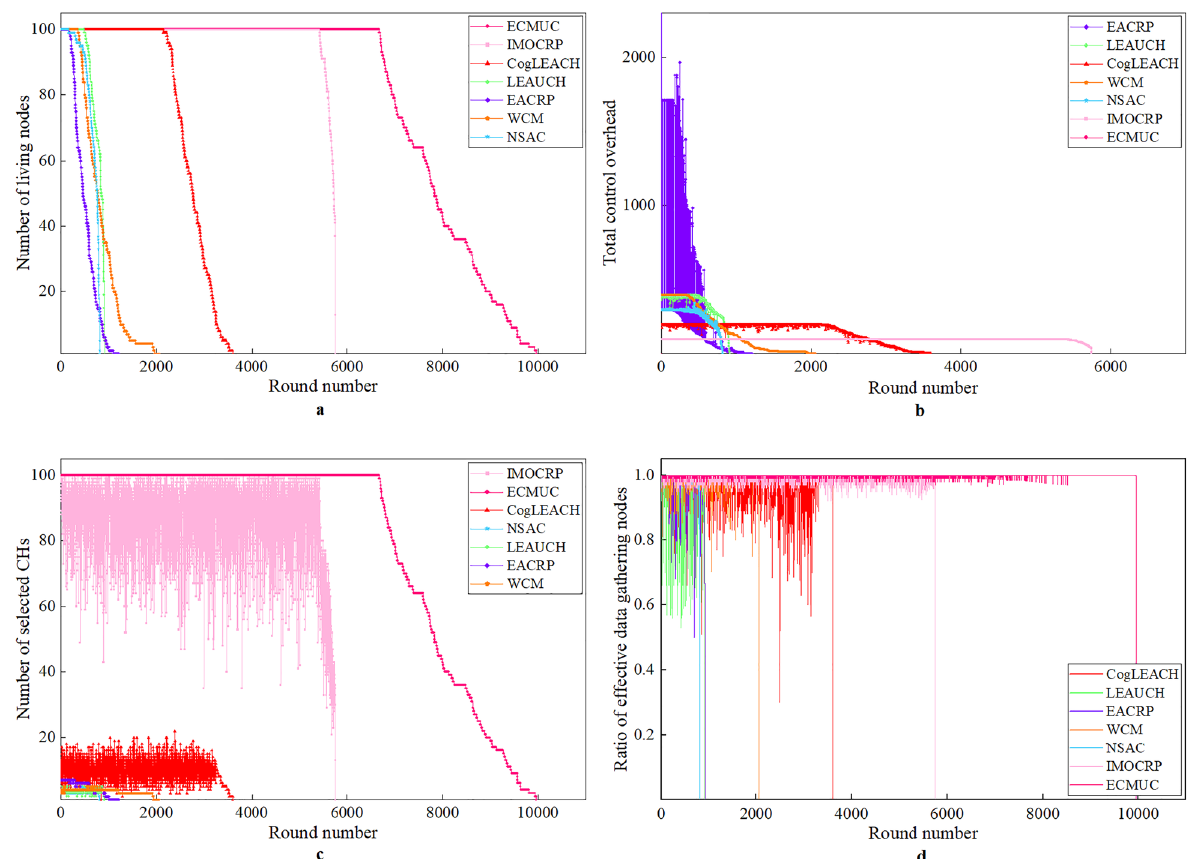
Figure 6. Performance comparison results in Case